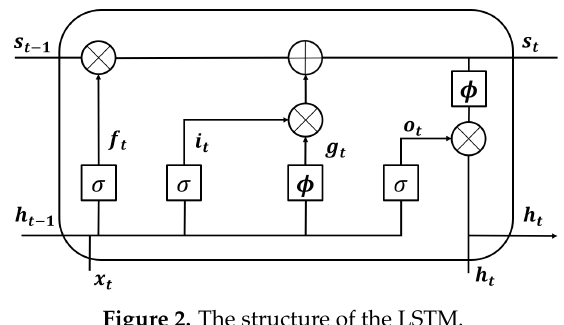
Figure 2. The structure of the LSTM.